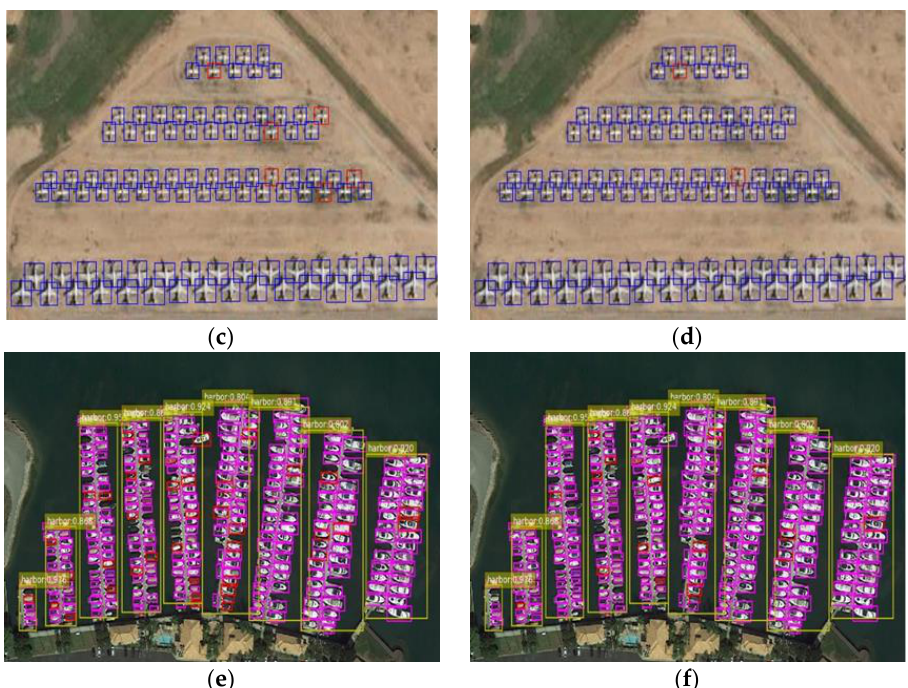
Figure 11. Small object detection results comparison. ( a , c , e ) are the detection results of the SSD algorithm; ( b , d , f ) are the detection results of our proposed CBFF-SSD algorithm. The red rectangle indicates incorrect detection.